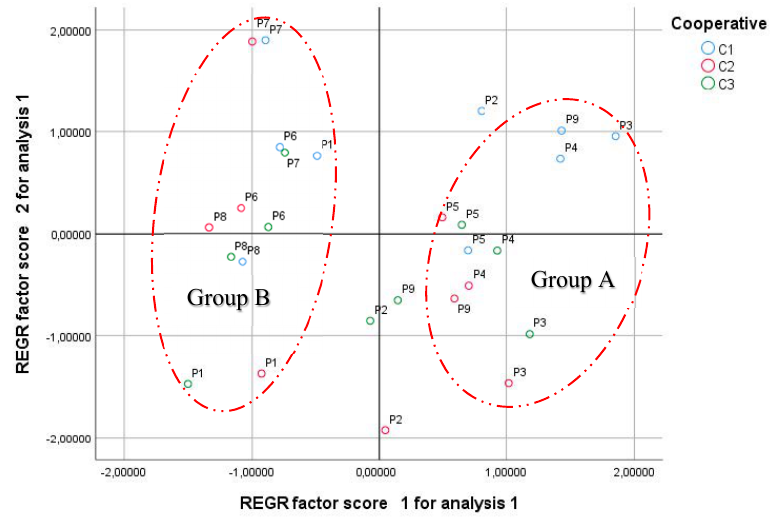
Figure 3. Projection of the cloud of individuals (score plot) in the first and second principal compo- nents. Pn: period of harvesting. Group A represents the summer season. Group B represents the winter season.